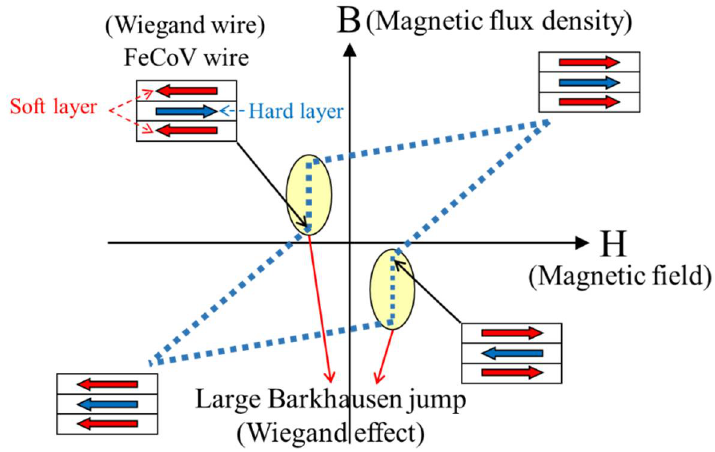
Figure 3. Schematic illustration of Barkhausen jump due to fast magnetization reversal between soft and hard layers of a Wiegand wire.